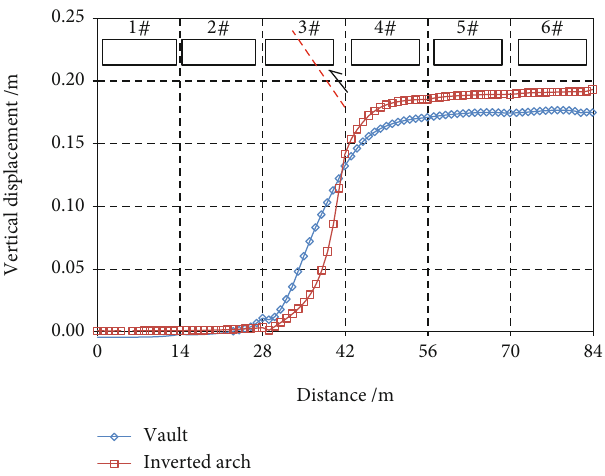
Figure 8: Deformation curve of segmental lining under fault